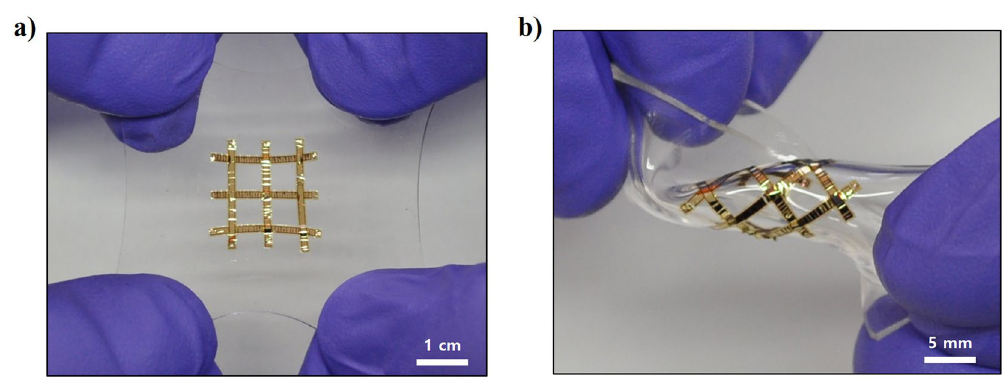
Figure 7. Photographs of the cross-buckled thin film solar cells. Cross-buckled thin film solar cells under ( a ) biaxially stretching state and ( b ) twisting